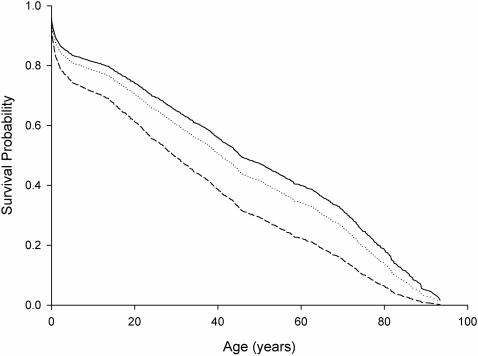
Estimated Kaplan-Meier survival curves for pre-industrial Finnish women belonging to the Rich (solid line), the Middle-class (dotted line), and the Poor (slashed line) parental wealth class, while adjusting for study parish and birth cohort.